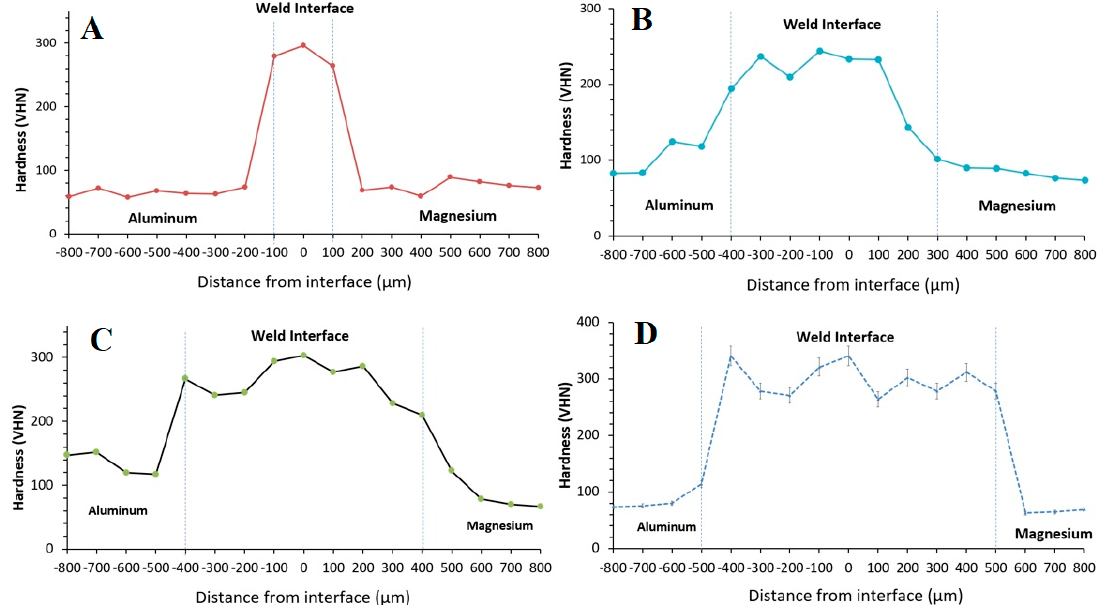
Figure 9. Microhardness profile across the weld nugget for samples joined with 800 N, 6.3 kVA for ( A ) 100 ms; ( B ) 200 ms; ( C ) 300 ms; and ( D ) 400